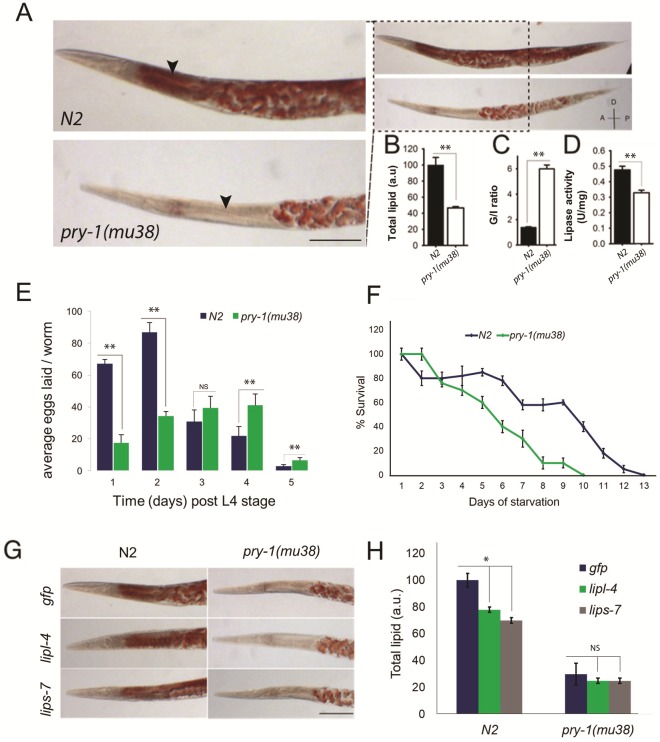
Lipid levels and distribution are altered in pry-1(mu38) mutants.Arrowheads indicate intestine and dotted areas gonad. (A) Representative DIC images of N2 and pry-1(mu38), stained with Oil Red O. D: dorsal; V: ventral; A: anterior; and P: posterior. (B, C) Quantification of Oil Red O staining. Data represents the mean of at least two replicates and error bar in this and subsequent graphs represents the SEM. (C) Ratio of gonadal to intestinal (G/I) lipid. (D) The lipase activity is decreased in pry-1(mu38). The activity per mg of protein has been plotted. (E) The average number of eggs laid by wild-type and pry-1(mu38) animals on different days over the duration of their reproductive period. (F) pry-1(mu38) displayed significant reduction in L1 survival following starvation. Percent survival of L1 larvae in the absence of food has been plotted. Graph represents the average of three independent experiments. (G) Representative images of N2 and pry-1(mu38) RNAi-treated animals stained with Oil Red O. (H) Histograms show Oil Red O intensities. Scale bar, 50 μm. *p < 0.01, **p < 0.001.